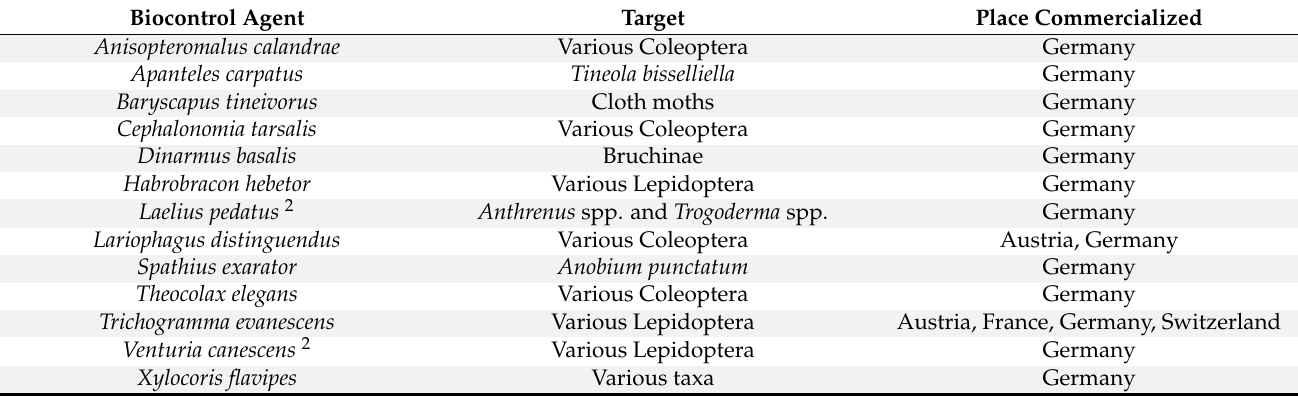
Table 3. Biocontrol agents commercialized against pests of stored products in Europe in 2021 1